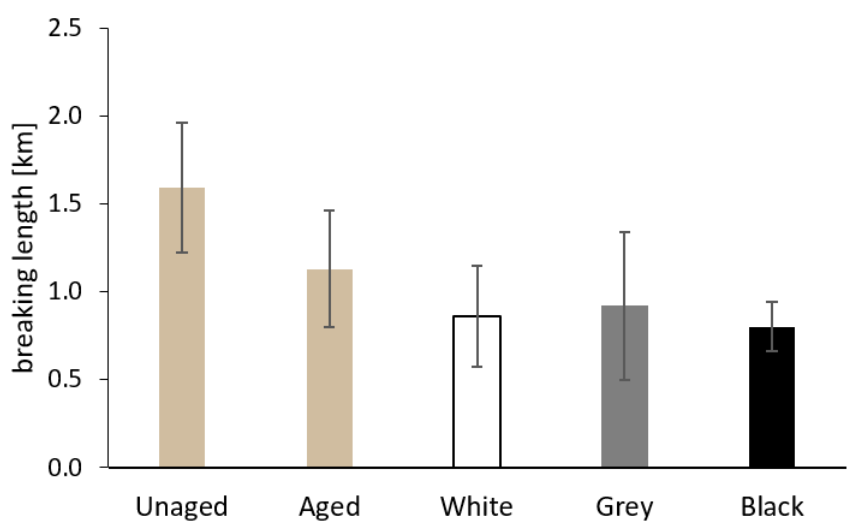
Figure 13. The breaking length of wood-pulp paper before aging (Unaged), after artificial aging without contact with PE foam (Aged), and in contact with the tested PE foams.